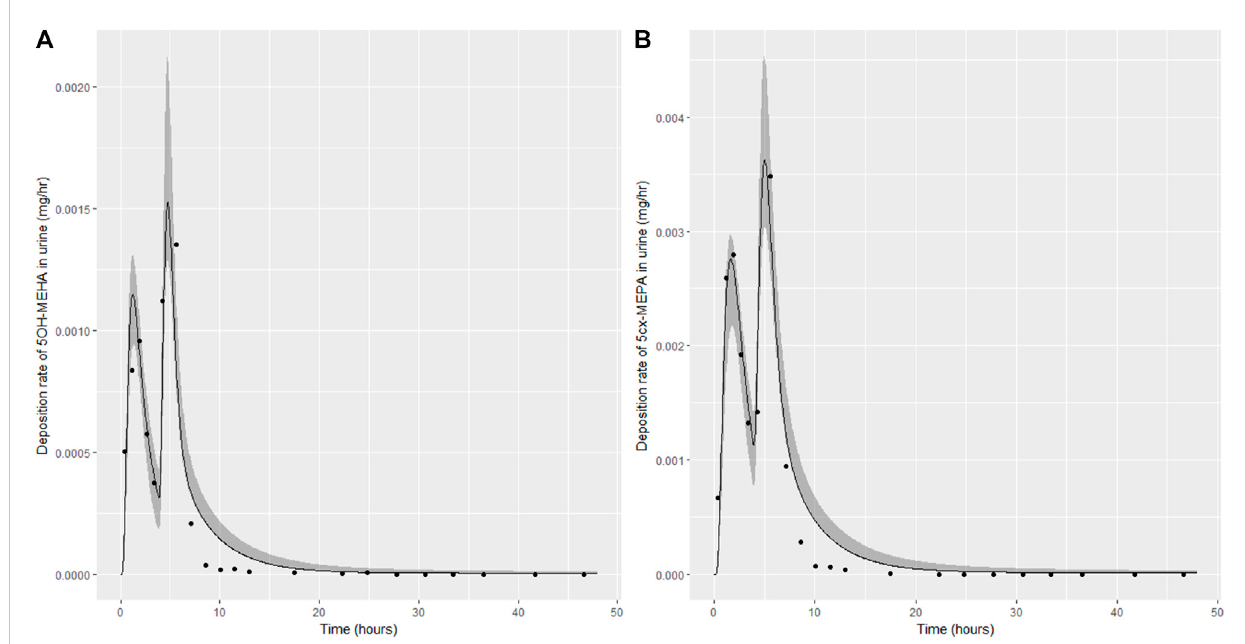
FIGURE 6 Simulation of the urinary excretion (mg/h) of 5OH-MEHA (A) and 5cx-MEPA (B) for volunteer C.